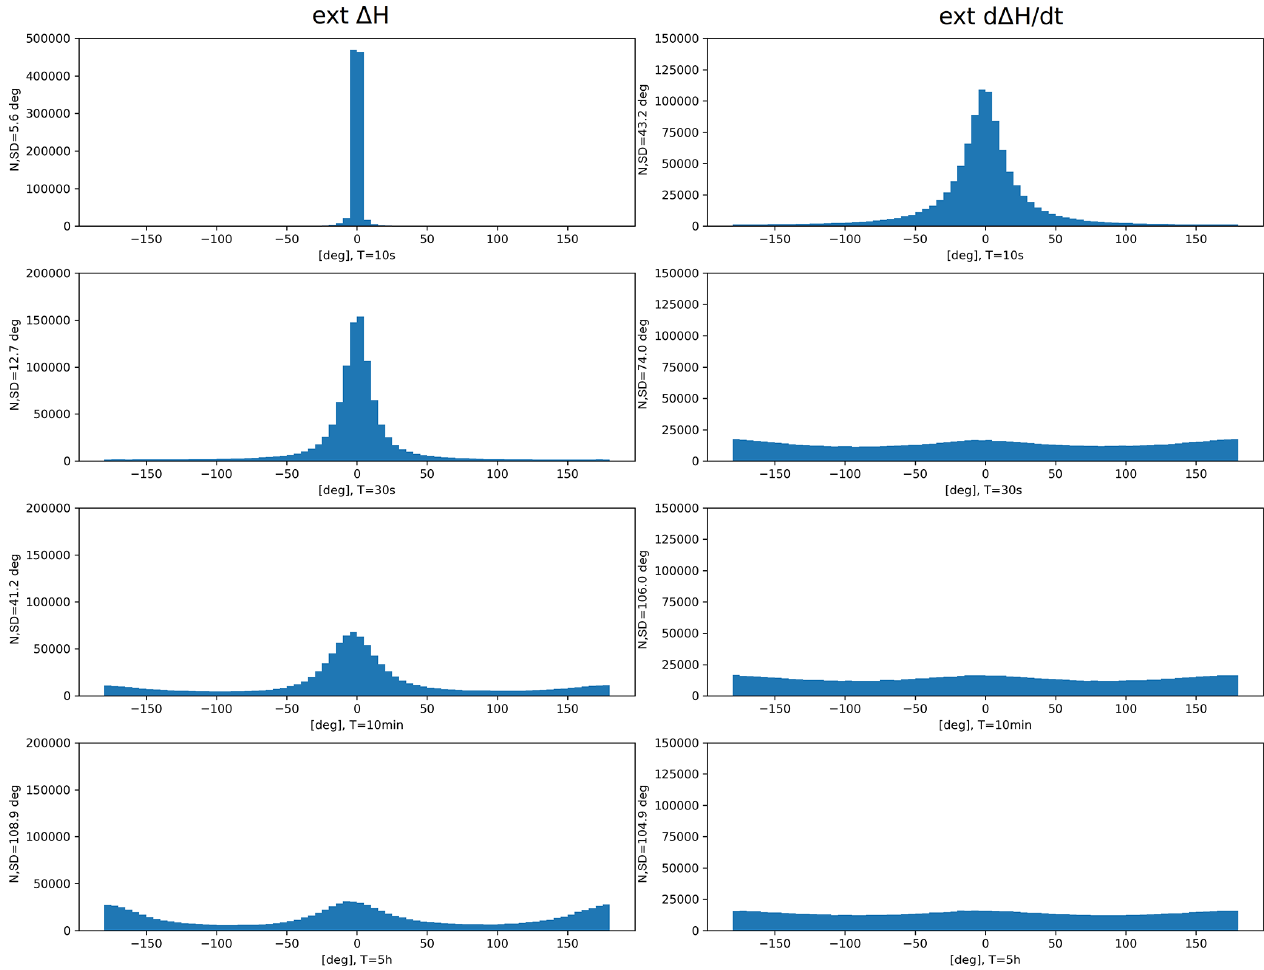
Figure B1. Histograms of (cid:49)θ at KIR at different time periods, T , using a threshold value 0.5nTs − 1 < | d (cid:49) H / d t | < 1nTs − 1 . On left: external (cid:49) H ; on right: external d (cid:49) H / d t .